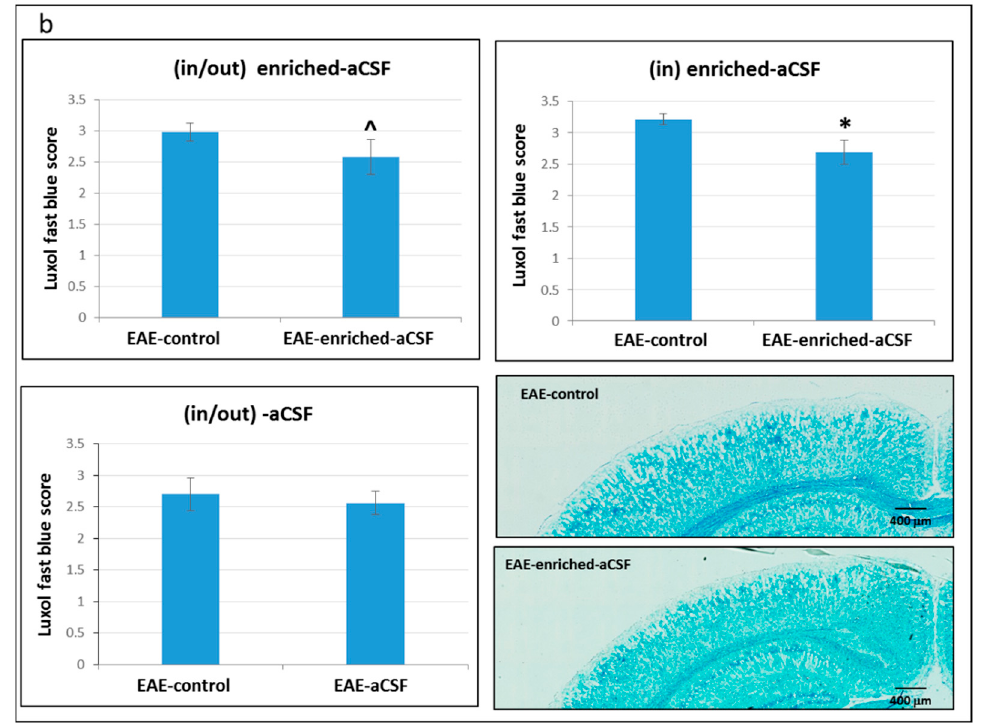
Figure 6. Reduced axonal damage and demyelination in the cortex of enriched-aCSF treated EAE-mice. ( a ) A significantly lower axonal damage in the Bielschowsky staining in the (in/out) enriched-aCSF treated mice relative to EAE-control mice was found (* p = 0.048). A similar trend was found in the prolonged treatment of (in) enriched-aCSF-mice relative to the EAE-control mice (ˆ p = 0.09), while no difference in the (in/out) aCSF-treatment vs EAE-control was detected; ( b ) A trend of less demyelination in the LFB staining in the (in/out) enriched-aCSF treated- mice relative to the EAE-control mice (ˆ p = 0.09), and a significant lower demyelination in the (in) enriched-aCSF-mice relative to the EAE-control mice (* p = 0.02) was found, and no difference in demyelination in the (in/out) aCSF-treatment vs EAE-control was shown.